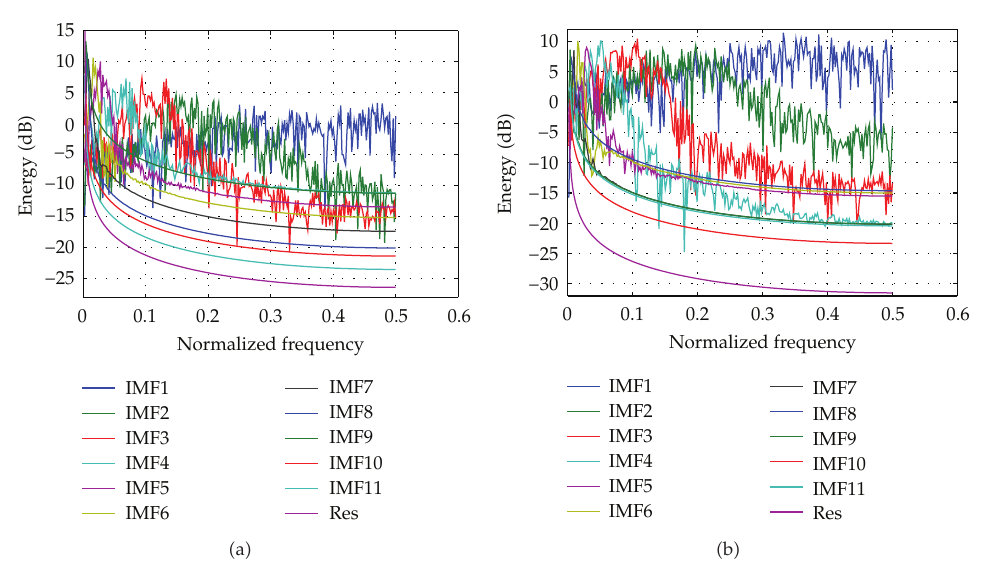
Figure 2: The Fourier spectra of the IMFs of (cid:2) a (cid:3) fractional Gaussian noise (cid:2) fGn (cid:3) and (cid:2) b (cid:3) climate signal (cid:2) daily evaporation (cid:3)